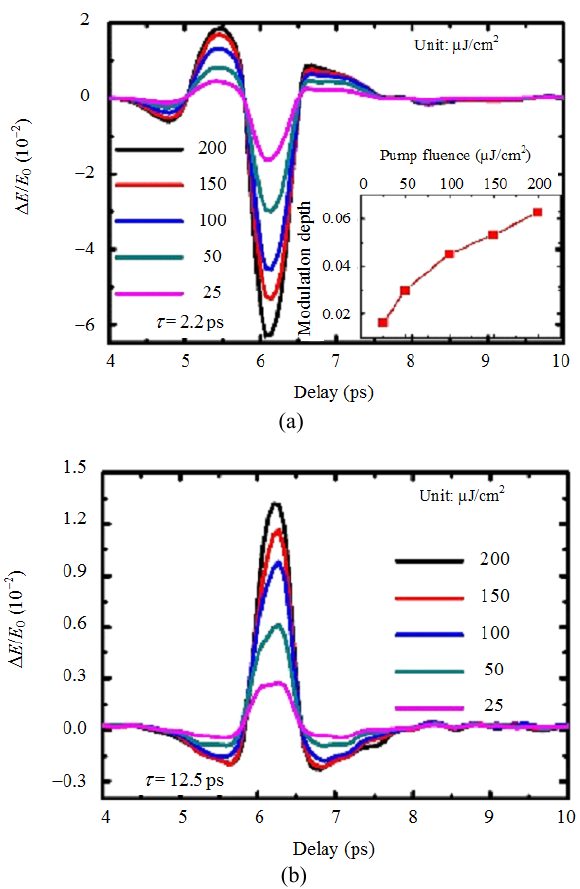
Fig. 3 Measured temporal THz wave transmitted through 8 QL Bi 2 Se 3 sample at the time delay of: (a) 2.2 ps and (b) 12.5 ps, respectively. The inset of (a) is the frequency averaged modulation depth as a function of pump